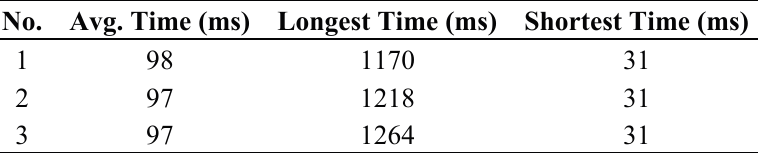
Figure 14. The impact of bandwidth congestion degree on the IoT device response time. Table 2. Command exchange response time by using HTTP.